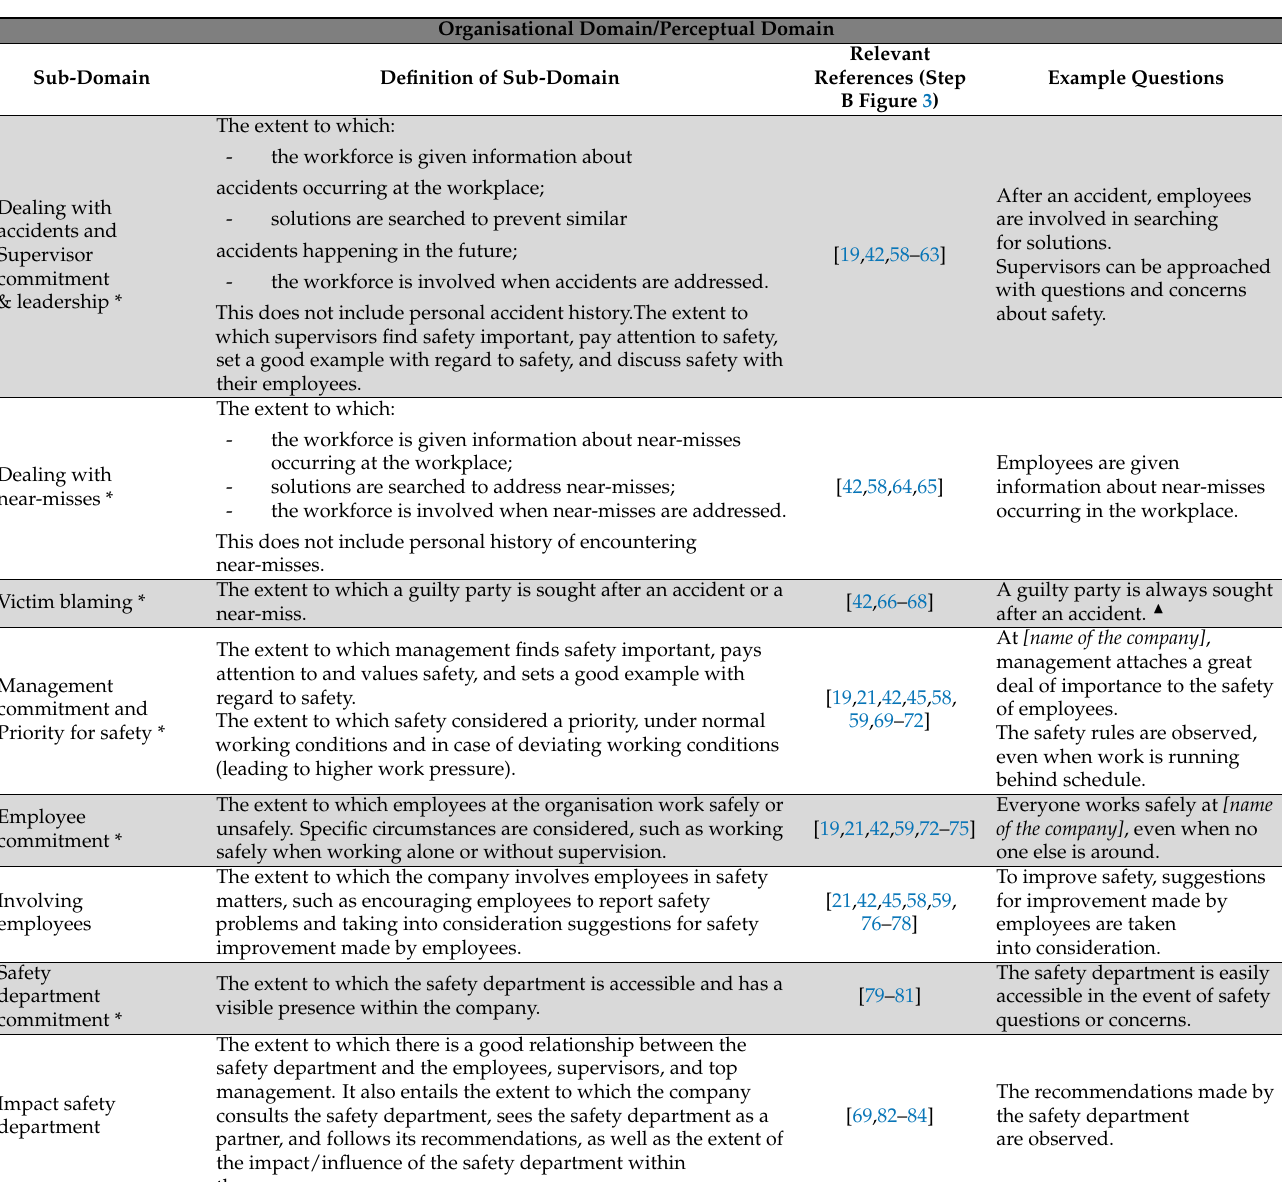
Table 8. Non-observable domains of safety culture and their